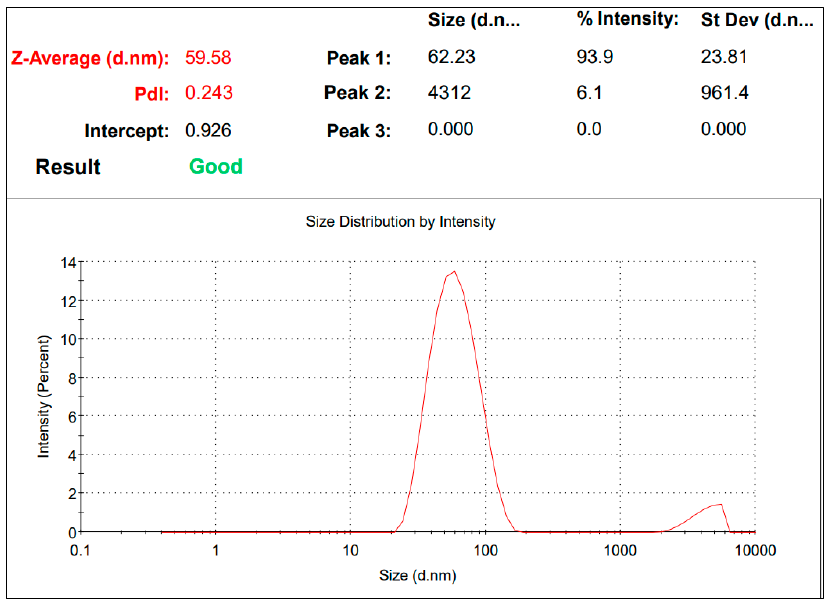
Figure 2. UV–Vis spectral wavelength for a batch of synthesized AgPtNPs (peak at 323 nm).